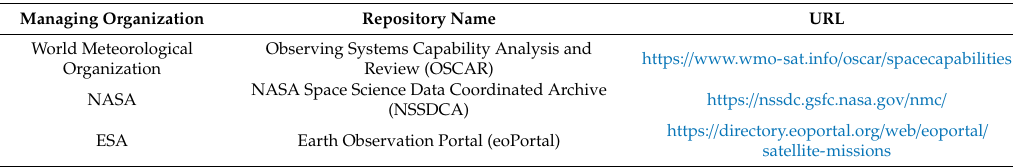
Table A1. List of online repositories of satellite remote sensing platforms, sensors, and managing agency